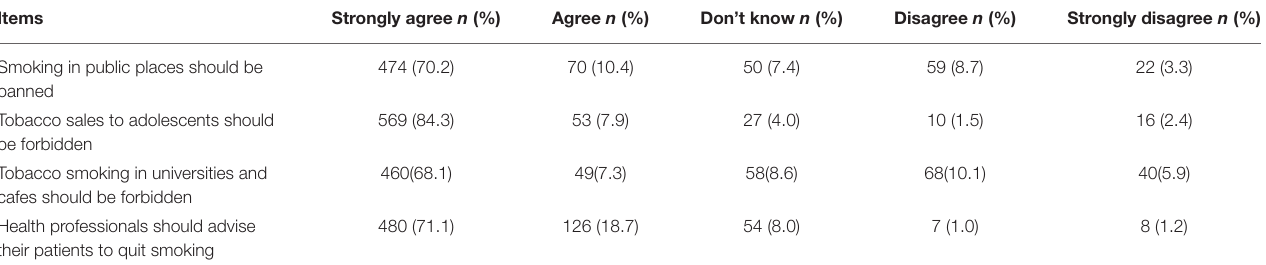
TABLE 3 | Beliefs of students toward smoking cessation ( n =